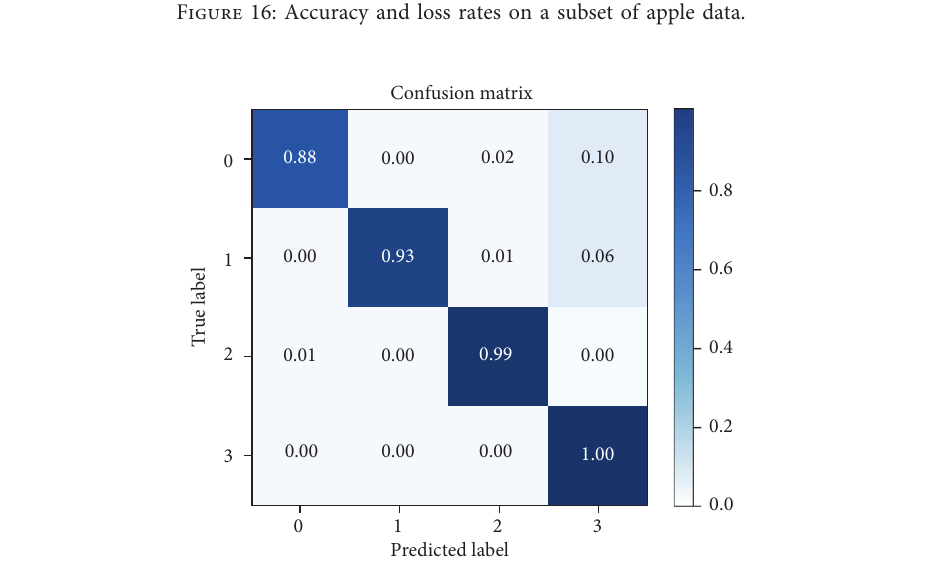
Figure 17: Confusion matrix of apple data